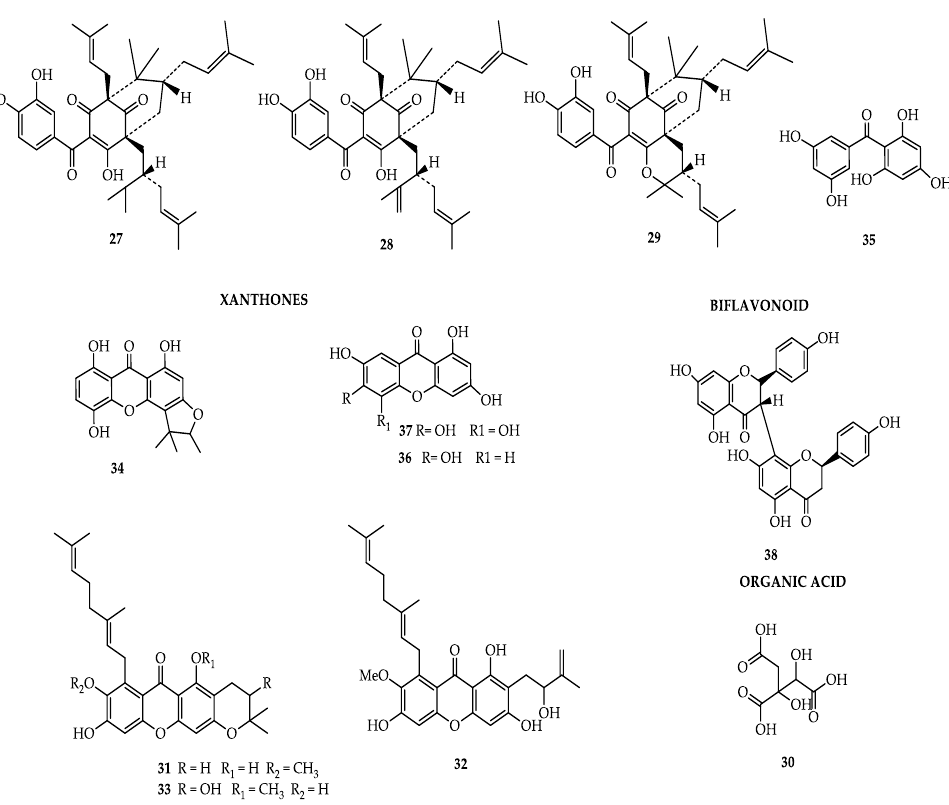
Figure 3. Bioactive compounds of Garcinia pedunculata .